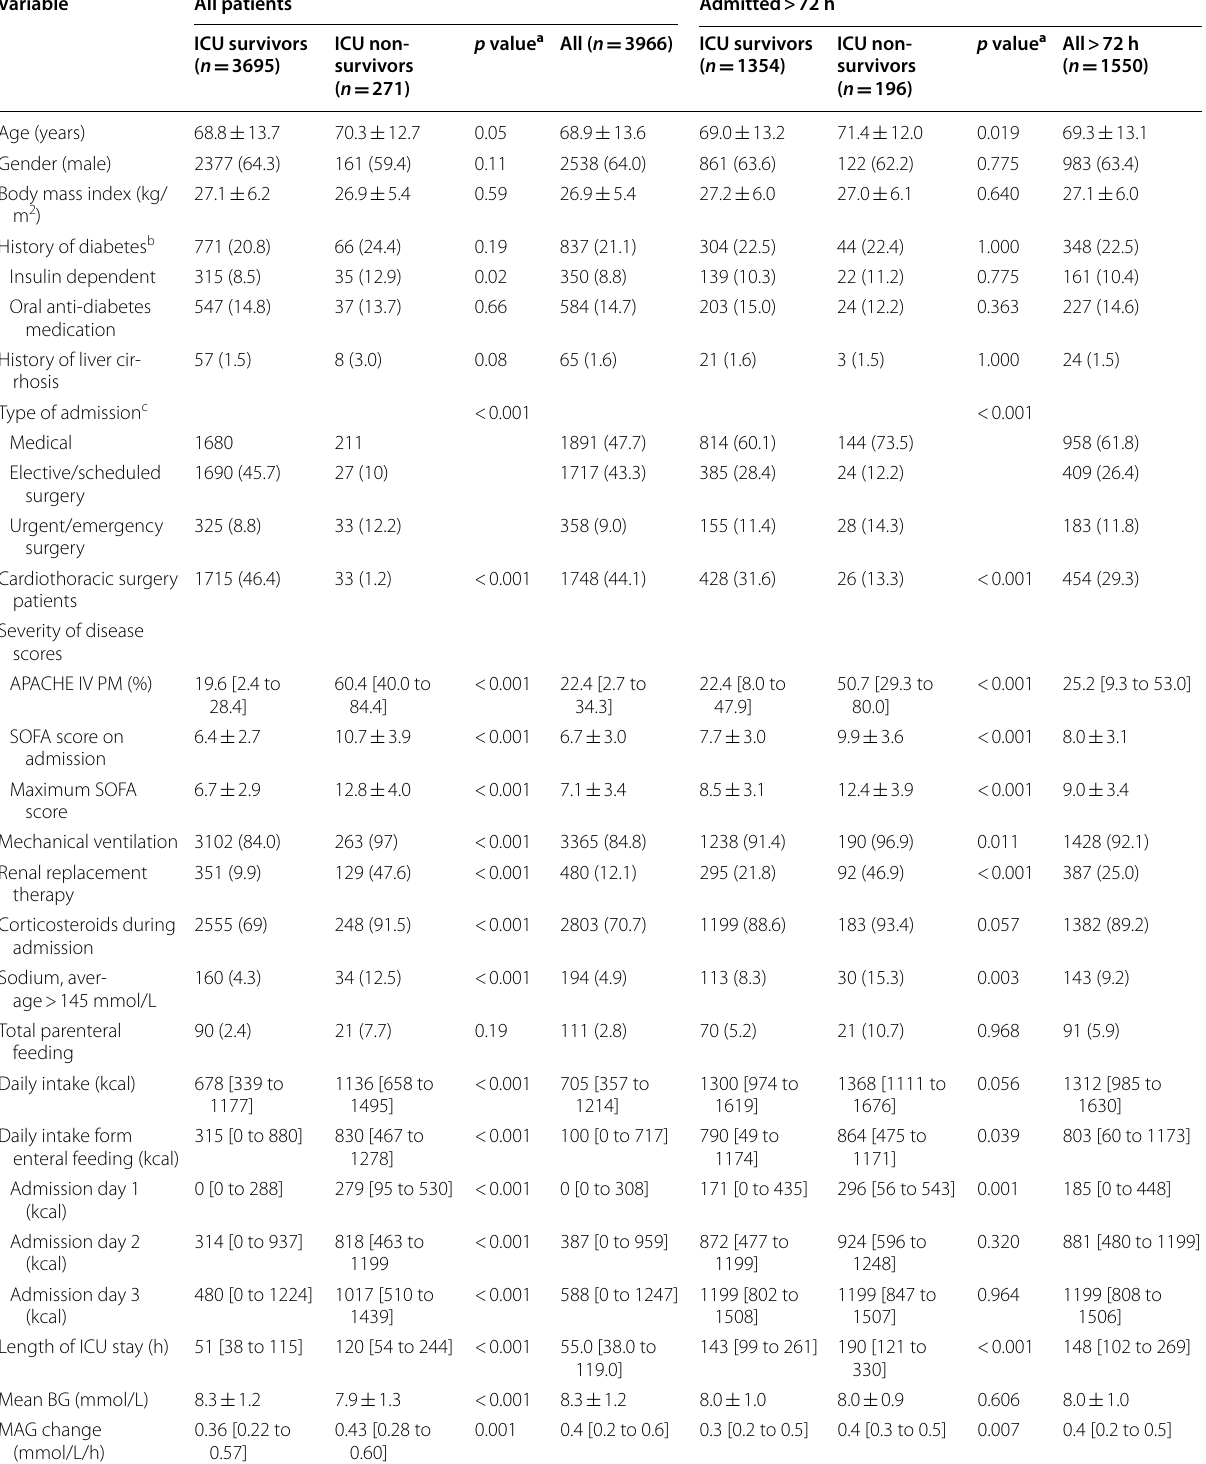
1550), comparing ICU survivors with non-survivors ( n =